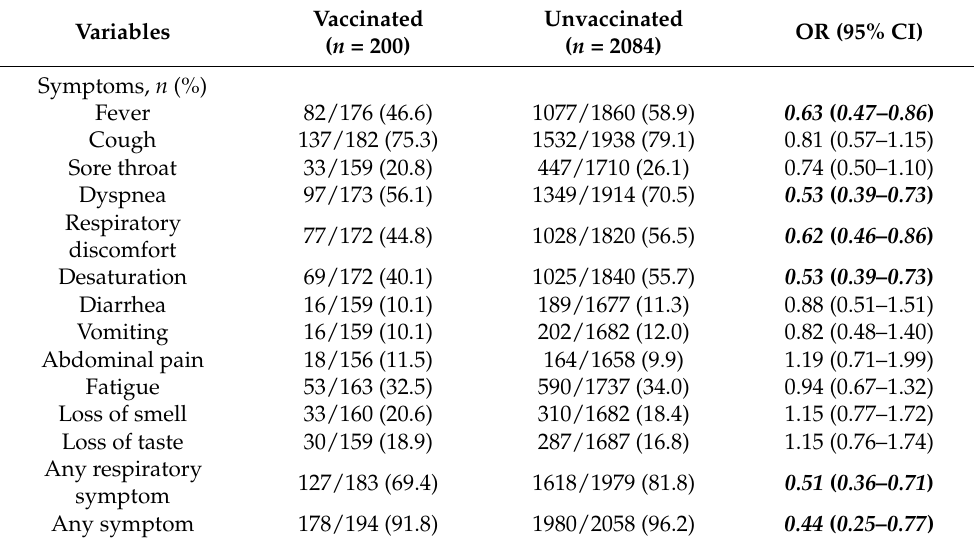
Table 2. Characteristics of COVID-19 symptoms by vaccination